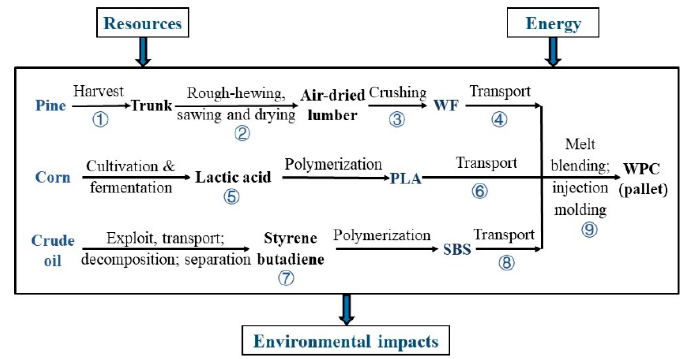
Figure 2. System boundary of this life cycle assessment (LCA) for the SBS-toughened, PLA-based WPCs.